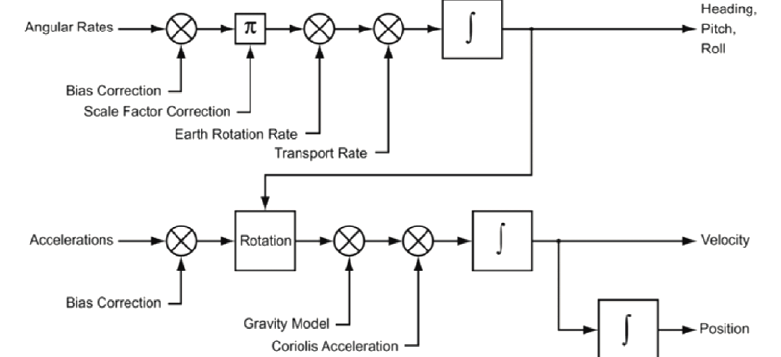
Figure 3. Schematic of the strapdown